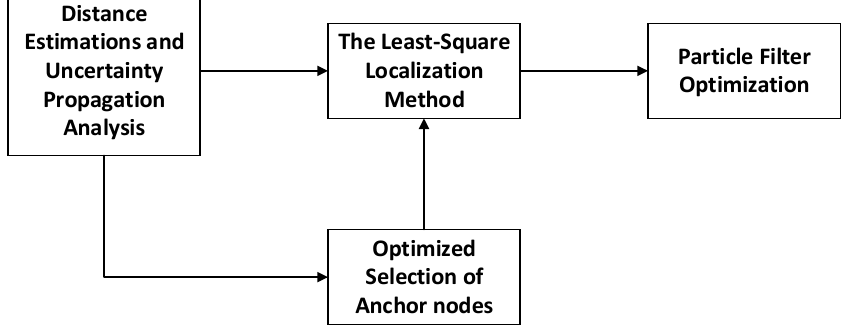
Figure 1. The framework of MSDO-PF and MEPO-PF localization method.